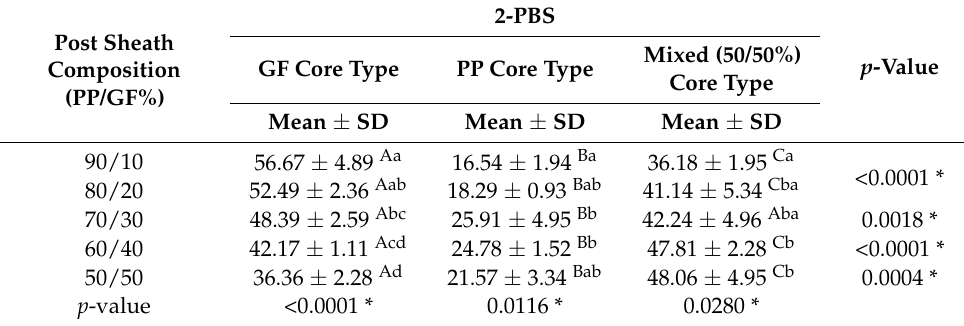
Table 3. Means and standard deviations (SD) of two-point bending flexural strength (2-PBS) (MPa) for first stage.